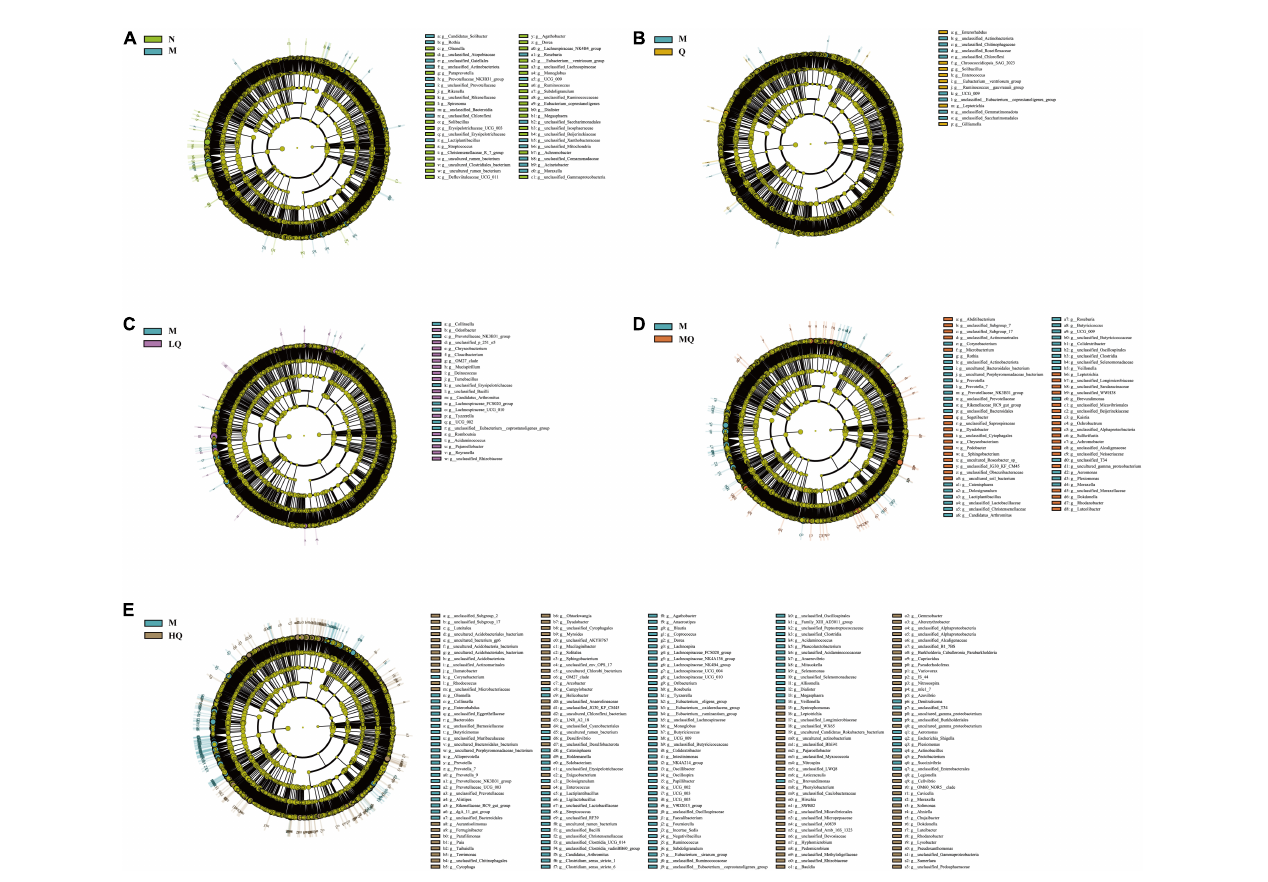
FIGURE6 Effect of different sucrose dose on the characteristic of intestinal mucosal microbiota in antibiotic-associated diarrhea (AAD) mice intervened by Qiweibaizhu powder (QWBZP). (A) N group and M group; (B) M group and Q group; (C) M group and LQ group; (D) M group and MQ group; (E) M group and HQ